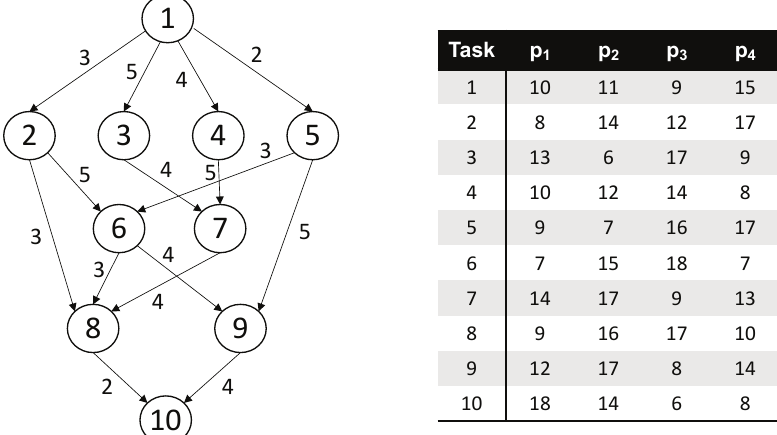
Figure 1. A sample workflow with 10 tasks and the complementary